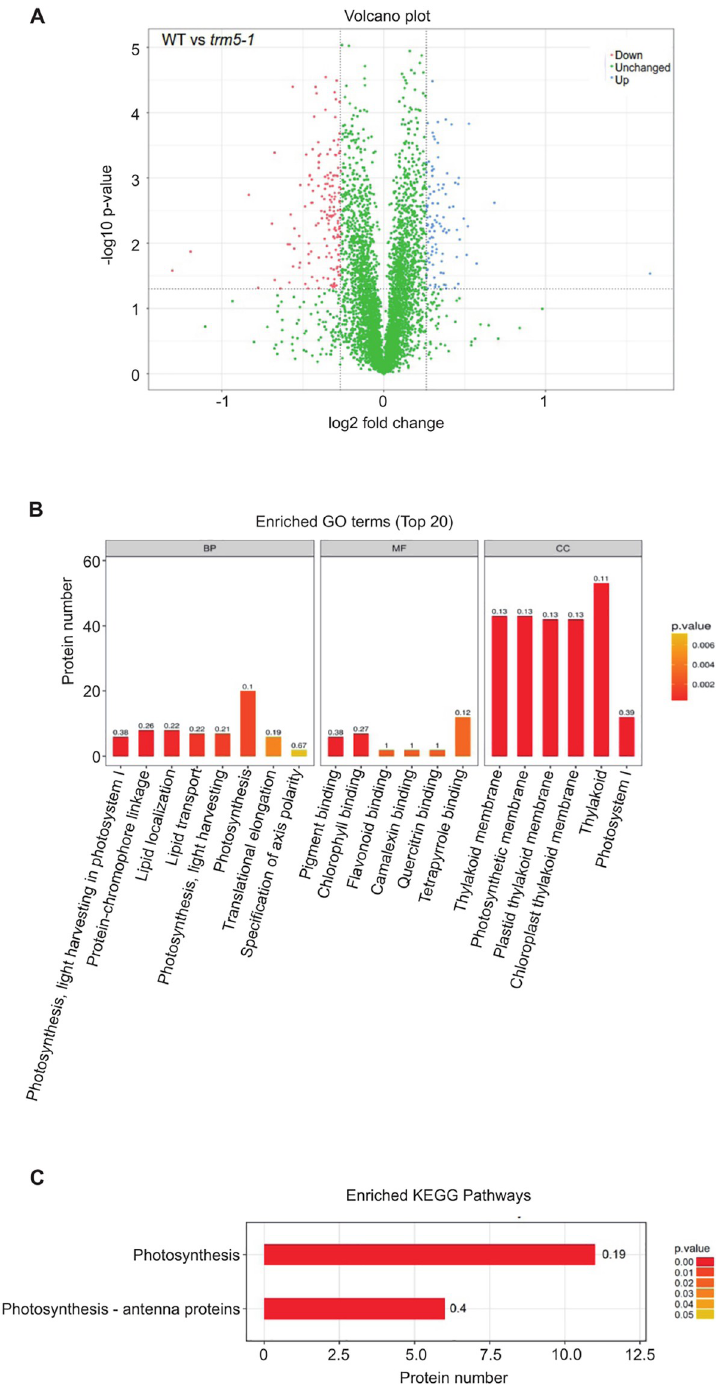
Fig 7. Proteomic analysis of wild type and trm5-1 . ( A ) Volcano plot of differentially abundant proteins between wild type and trm5-1 . In trm5-1 , proteins that were increased in abundance are represented as blue dots, proteins decreased in abundance as red dots, with threshold fold change > 1.2 or < 0.83 (increased or decreased) and P -value < 0.05. There were 102 proteins increased and 161 proteins decreased in trm5-1 . ( B ) GO and ( C ) KEGG terms enrichment analysis. Each differentially abundant protein was first annotated in the GO or KEGG databases, enrichment analysis was performed based on annotated differentially expressed proteins in wild type and trm5-1 . The top 20 enriched GO terms from Biological Processes (BP), Molecular function (MF), and Cellular Component (CC) are reported.